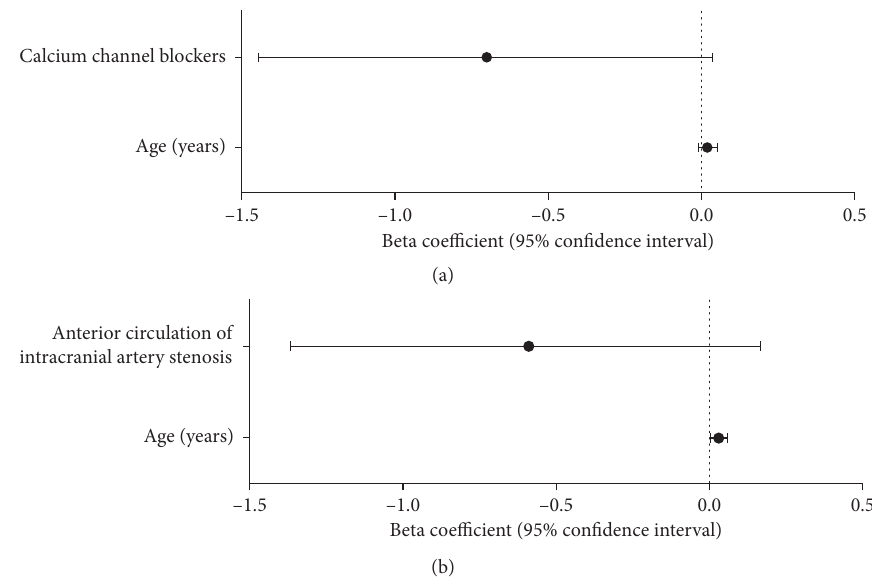
Figure 1: Results of multivariable analyses for coefficient of variance (CV) of systolic blood pressure (SBP) (a), coefficient of variance (CV) of diastolic blood pressure (DBP) (b) in patients receiving angiography examination within 3 days after disease onset, and the results of CV of SBP (c) in patients receiving angiography examination 3 days after ( ≥ 3 days) disease onset. Natural log transformation was applied to the CV of BP, and beta coefficients were estimated by linear regression with the backward method. CI; confidence interval; NIHSS: